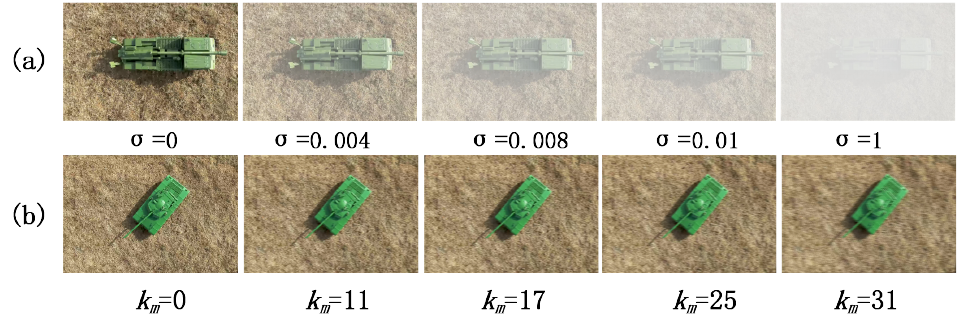
Figure 5. Images with fog and motion blur.